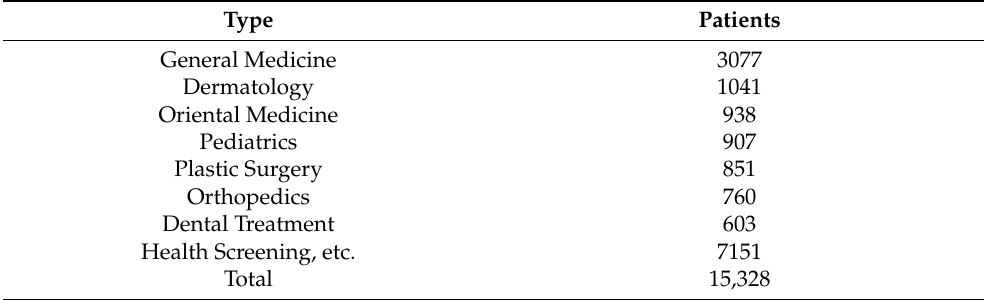
Table 5. The Middle East: types of medical treatments (2019). Type Patients General Medicine 3077 Dermatology 1041 Oriental Medicine 938 Pediatrics 907 Plastic Surgery 851 Orthopedics 760 Dental Treatment 603 Health Screening, etc. 7151 Total